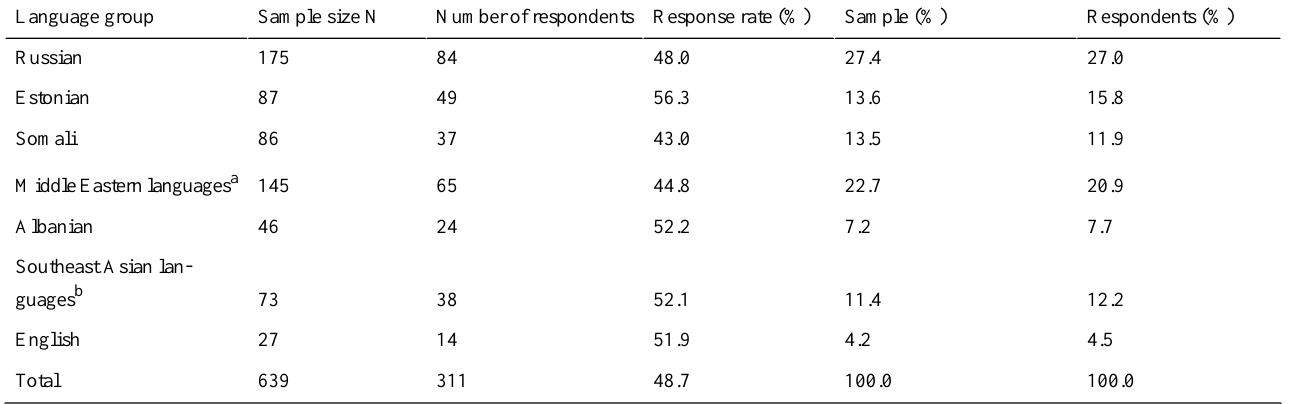
Table 1. Sample size, number of respondents, response rate, and the distribution of language groups among sample and